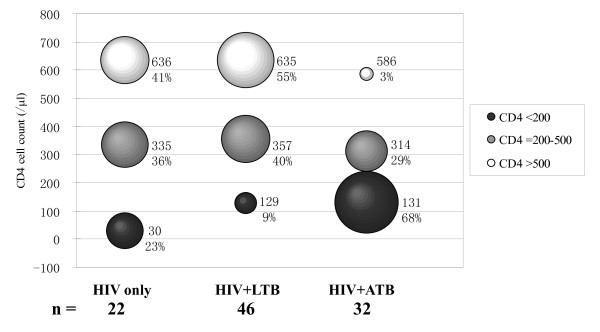
The distributions of subjects with different CD4+ T cell counts in HIV only, HIV+LTB, and HIV+ATB groups. The black bubbles represent CD4+ T cells <200/μl, the gray bubbles represent CD4+ T cells 200–500/μL, and the white bubbles represent CD4+ T cells >500/μl. The sizes of the bubbles represent the percentage of patients with appropriate CD4+ T cell counts.